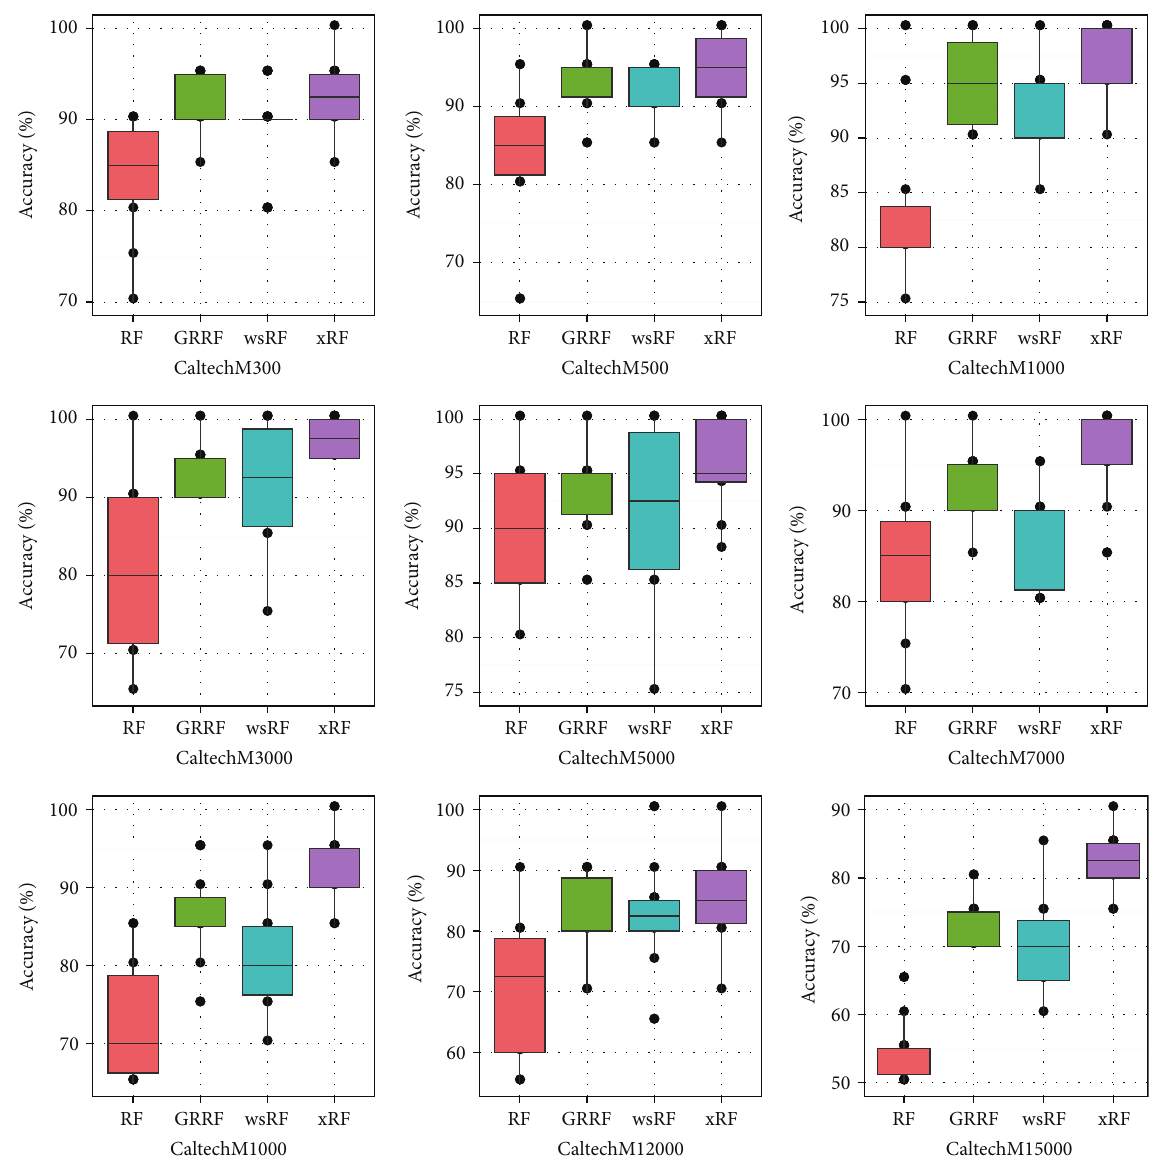
Figure 3: Box plots: the test accuracy of the nine Caltech